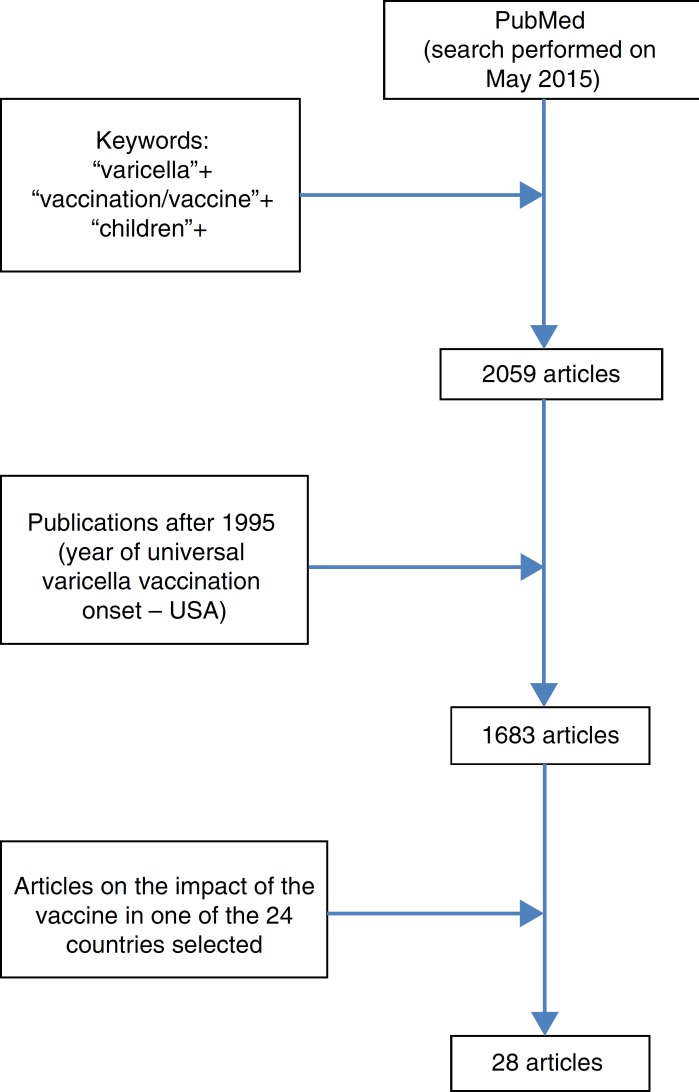
Search performed in PubMed.